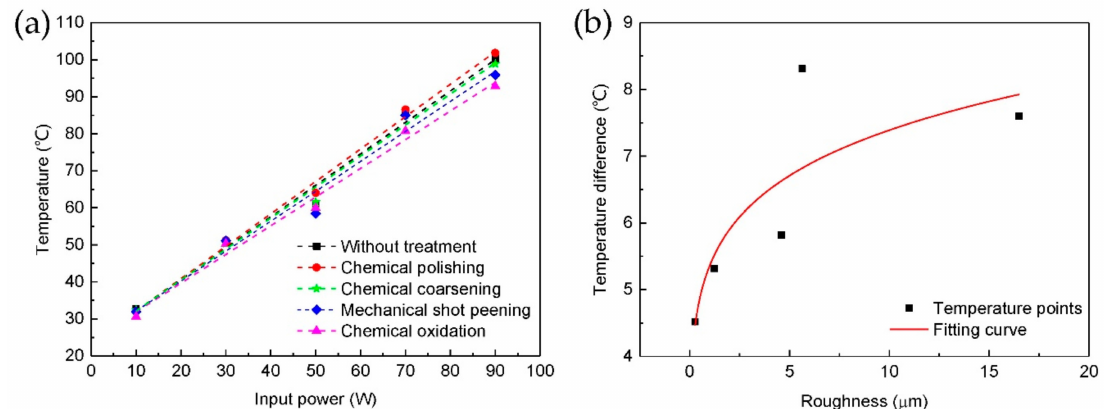
Figure 9. Temperatures of heat sinks with thermal radiation coating in wind tunnel: ( a ) influence of different treated surface under the coating; ( b ) temperature difference of heat sinks with and without coating at different surface roughness (heating power 90